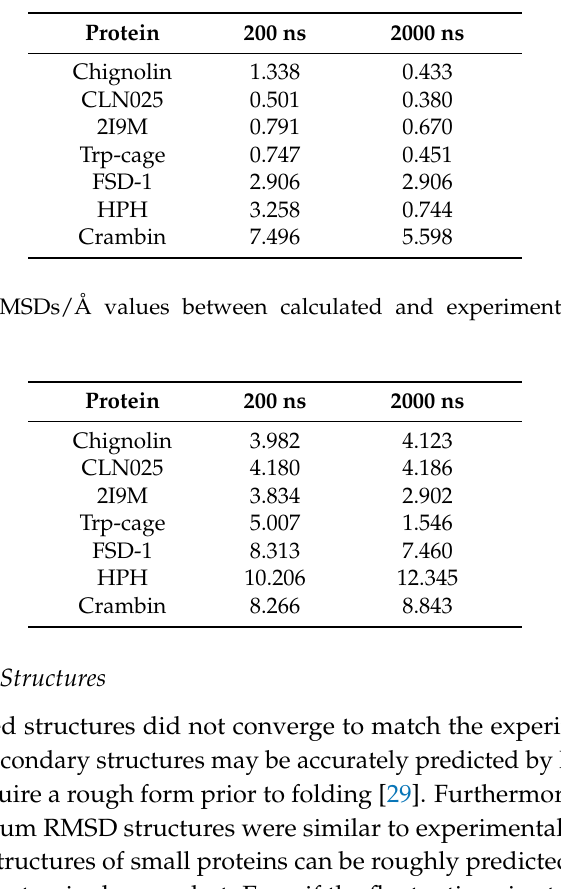
Table 2. The minimum RMSDs/Å values between calculated and experimental structures during MD trajectories.